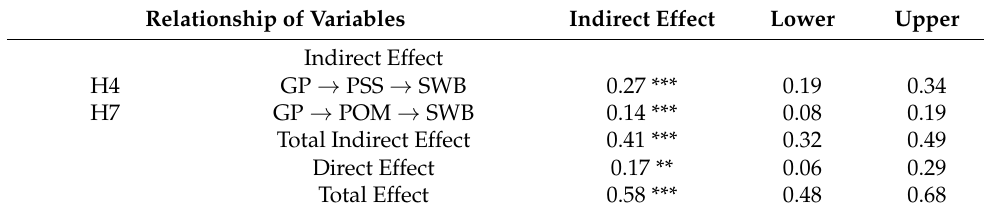
Table 7. Results of indirect effect analysis of Model